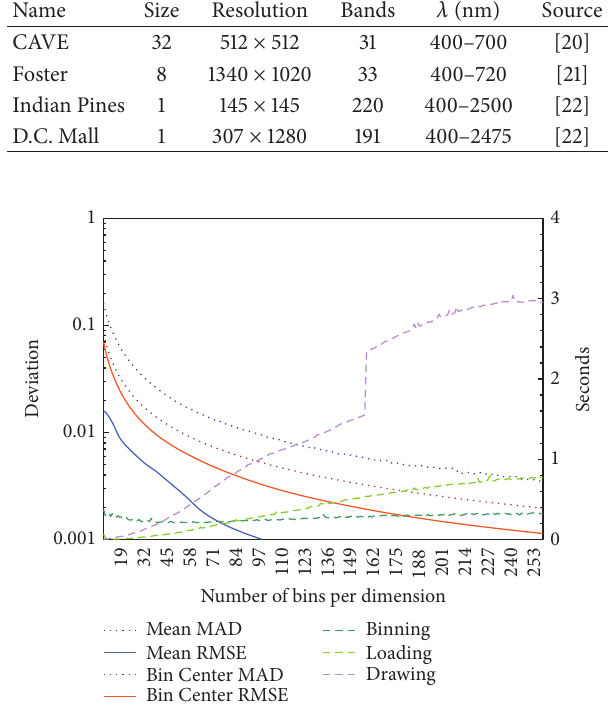
Figure 4: Experimental results on a scene from the Foster dataset. Quantization errors are plotted for both the old (Bin Center) and the refined (Mean) drawing method.